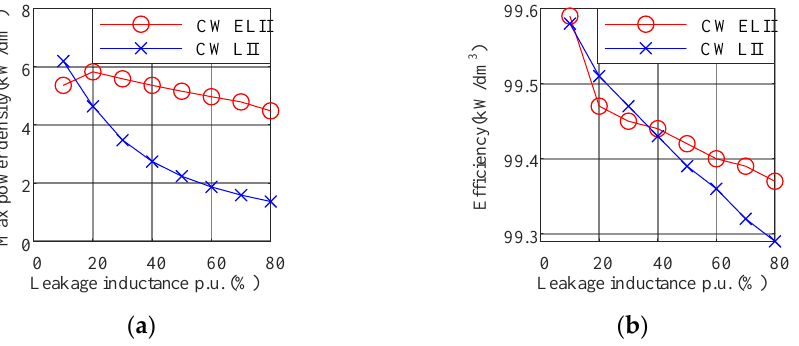
Figure 22. Comparison of solutions for different inductance requirements. ( a ) Max power density; ( b ) efficiencies.